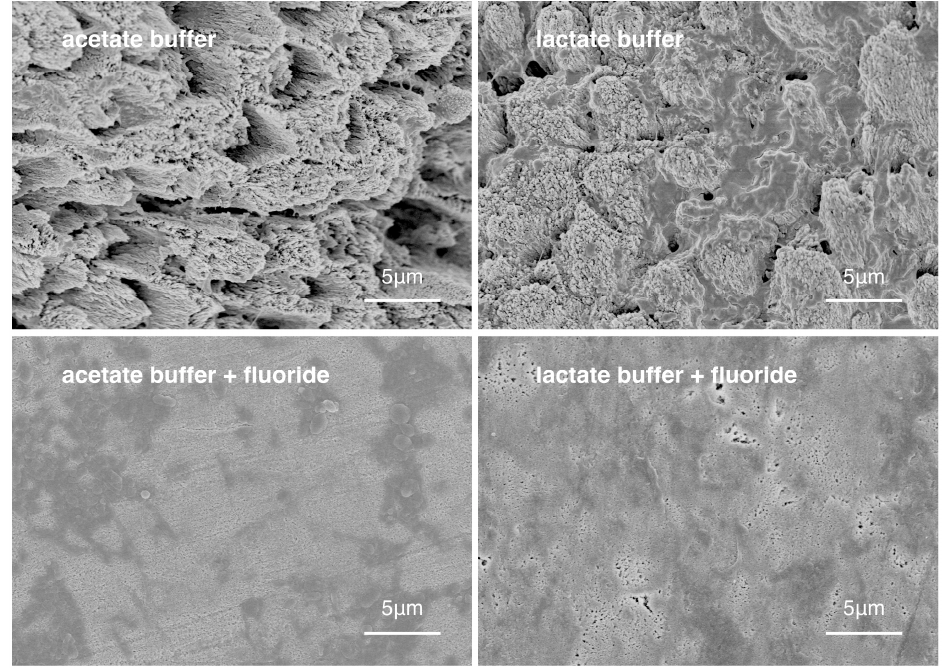
Figure 2. Surface morphology of enamel of the four experimental groups.